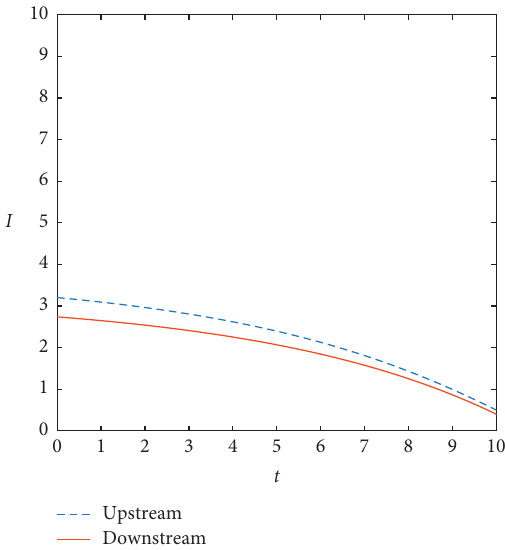
Figure 8: Optimal trajectory of pollution abatement investment under cooperation when T �